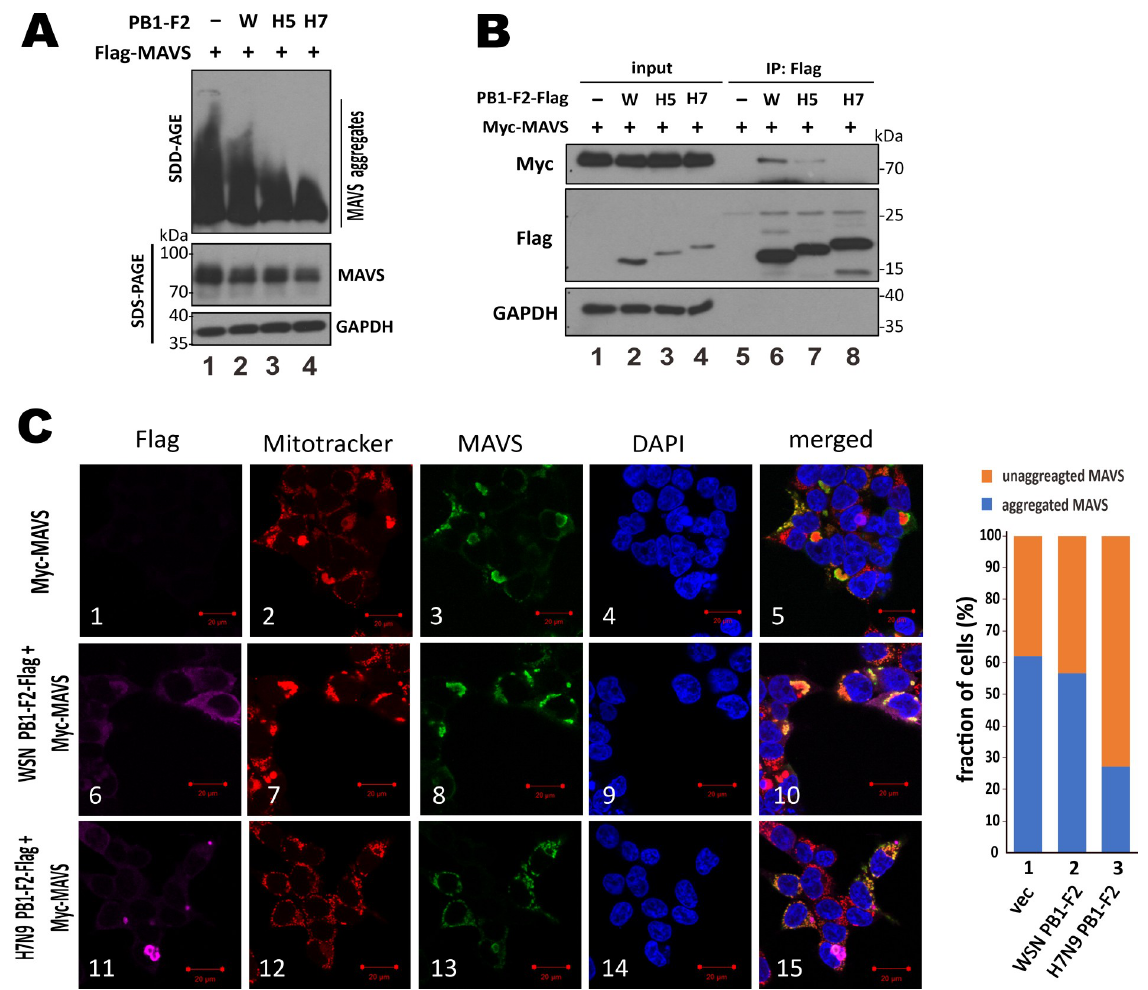
Fig 7. Suppression of MAVS aggregation by H7N9 PB1-F2. ( A ) SDD-AGE analysis of MAVS aggregation. HEK293T cells in 6-well plates were co-transfected with 1 μ g pEF-Bos-Flag-MAVS and 0.2 μ g expression construct for PB1-F2 of WSN, H5N1 or H7N9 virus. After 48 hours, cells were harvested for SDD-AGE or SDS-PAGE followed by Western blot analysis with anti-MAVS. ( B ) Co-immunoprecipitation assay for PB1-F2-MAVS association. HEK293T cells in 60mm dishes were co-transfected with 1 μ g pCAGEN-myc-MAVS and 0.5 μ g PB1-F2-Flag expression construct. After 48 hours, cells were harvested for co-immunoprecipitation with anti-Flag (IP: Flag). Both input and immunoprecipitates were analyzed by SDS-PAGE and Western blot analysis with anti-Myc for MAVS, anti-Flag for PB1-F2 and anti-GAPDH for normalization. ( C ) Distribution of unaggregated MAVS on fissioned mitochondria in cells expressing H7N9 PB1-F2. HEK293T cells in 6-well plates were co-transfected with 0.25 μ g of CAGEN-V5-MAVS and 0.25 μ g of PB1-F2-Flag expression constructs. After 48 hours, cells were stained with 500 nM Mitotracker Red CMXRos for 30 min and then fixed with 4% paraformaldehyde and probed with anti-Flag for PB1-F2, anti-MAVS and DAPI. The stained cells were analyzed by confocal microscopy. Fractions of cells with unaggregated and aggregated MAVS were calculated by counting 100 cells per sample. Aggregated MAVS or PB1-F2 was visually defined as concentrated dots or structures with intense MAVS or PB1-F2 signal. Bars, 20 μ m. Similar results were obtained from three independent experiments.